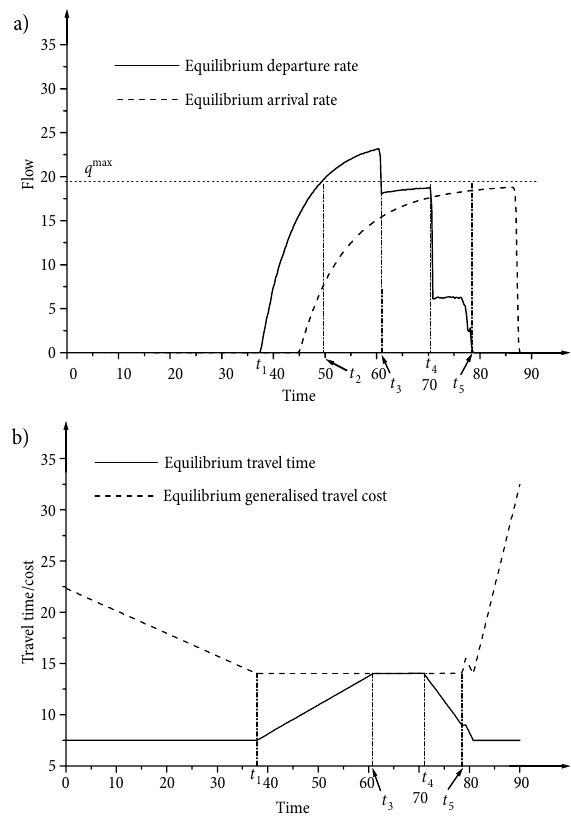
Fig. 3. Profiles of solutions to the example in Subsection 1.3: